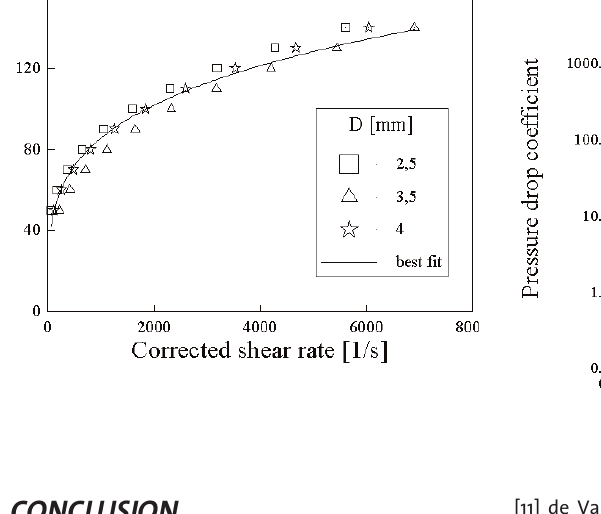
Figure 11 (left): Corrected flow curves for a 0.3% PEO foam. Figure 12 (right): Pressure drop coefficient, λ, (Fanning friction factor) as a function of corrected generalised Reynolds num- ber for a 0,3% PEO foam and different